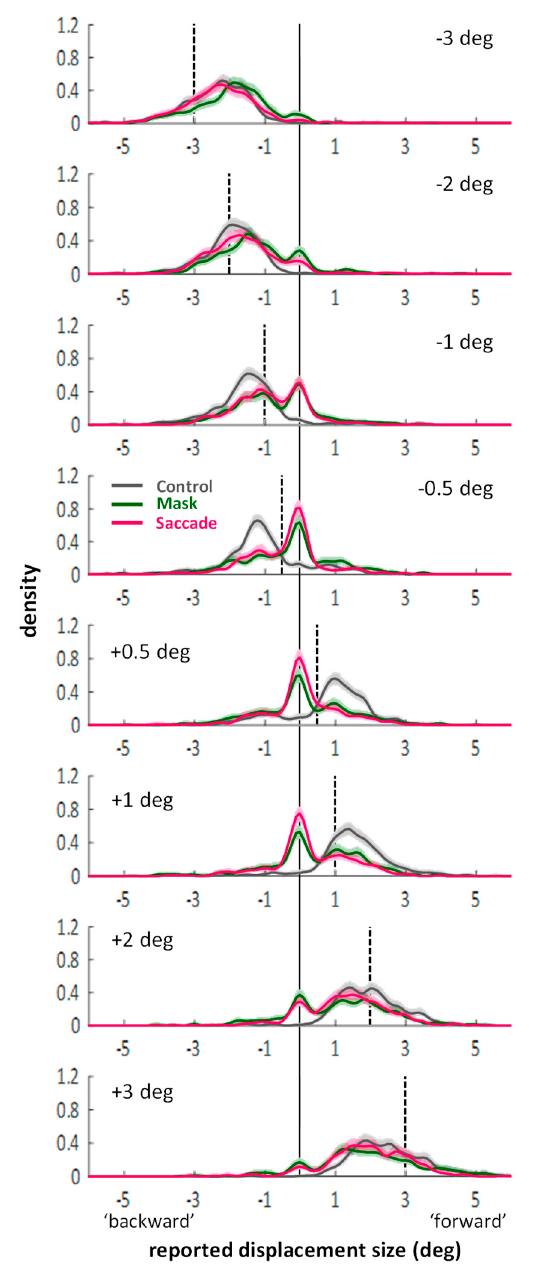
Figure A1. Distribution of responses (kernel density functions) in the three conditions of Experiment 1 (color-coded). Rows represent the di ff erent displacement sizes tested. Data are collapsed across all 28 participants. Shadings represent bootstrapped 95% confidence intervals. Vertical black continuous line: zero line. Vertical black dashed lines: actual displacement for each graph. Compared to actual displacements, the larger ± 2 and ± 3 deg displacements were underestimated in all conditions (distributions shifted towards zero compared to the dashed lines). The smaller ± 0.5 and ± 1 deg displacements, however, were overestimated in the control condition. Missed displacements, i.e., peaks around zero emerged for all displacements in the saccade and mask conditions and became more frequent with smaller displacements. All in all, distributions in mask and saccade conditions resembled each other, while distributions in the control conditions were markedly di ff erent for smaller displacements as virtually no misses occurred.